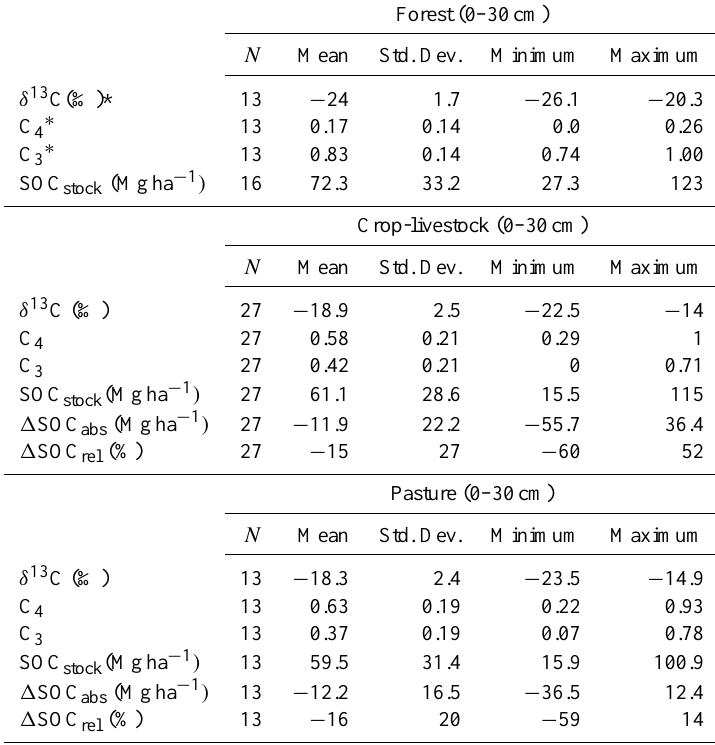
Table 3. Mean, standard-deviation (Std. Dev.), minimum and maximum for δ 13 C, C 3 proportion, C 4 proportion, and carbon stocks (SOC stock ) at 0–30cm soil depth layer for forest, crop-livestock systems and pasture soils at paired study sites. 1 SOC abs is the differ- ence between the carbon soil stock of native vegetation and crop-livestock systems and pasture soils obtained in the paired study sites. 1 SOC rel is the same difference expressed as percentage. Carbon losses are indicated by a minus sign (–). Forest (0–30cm) Std.